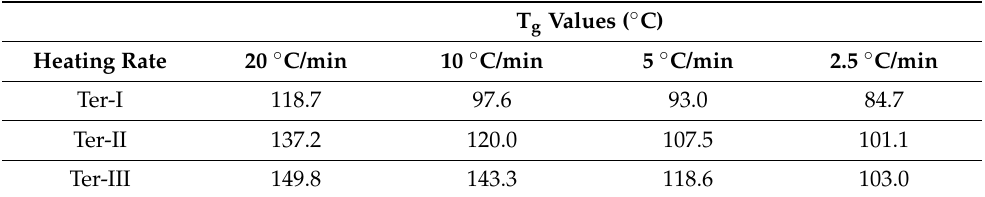
Table 4. Evaluation results of the T g values of the terpolymers at different heating